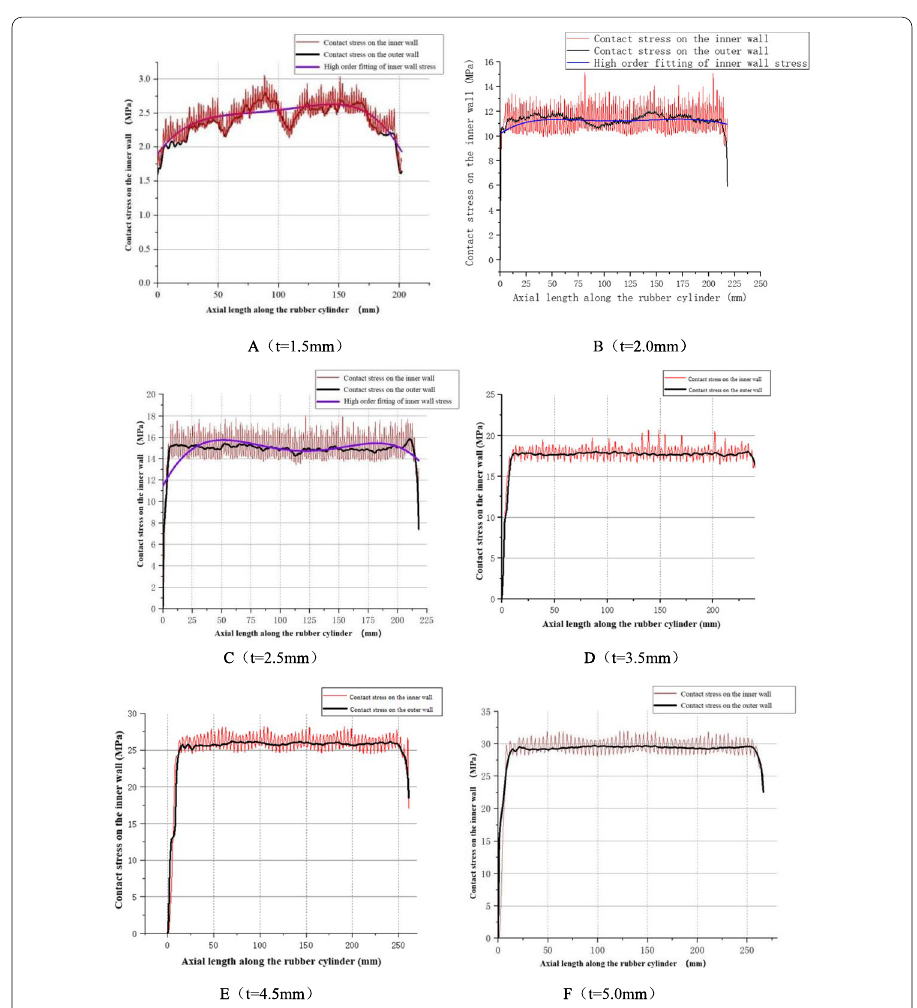
Fig. 9 Contact stress distribution of the inner and outer walls of the rubber